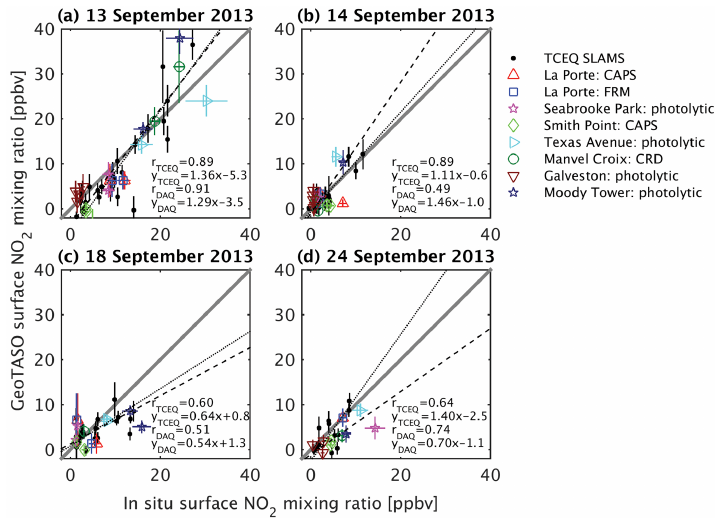
Figure 14. In situ surface NO 2 mixing ratios from the TCEQ SLAMS network and DISCOVER-AQ campaign research instrumentation vs. inferred surface NO 2 mixing ratios from GeoTASO for cloud-free observations during four Houston urban flights during DISCOVER-AQ 2013. Correlation coefficients and regression results are shown for TCEQ monitors (TCEQ) and for the CAPS, photolytic converter and CRD monitors deployed during DISCOVER-AQ (DAQ). GeoTASO error bars represent fitting uncertainties. The gray line represents the 1 : 1 ratio. The black dashed (DISCOVER-AQ sites) and black dotted (TCEQ SLAMS) lines represent reduced major axis linear